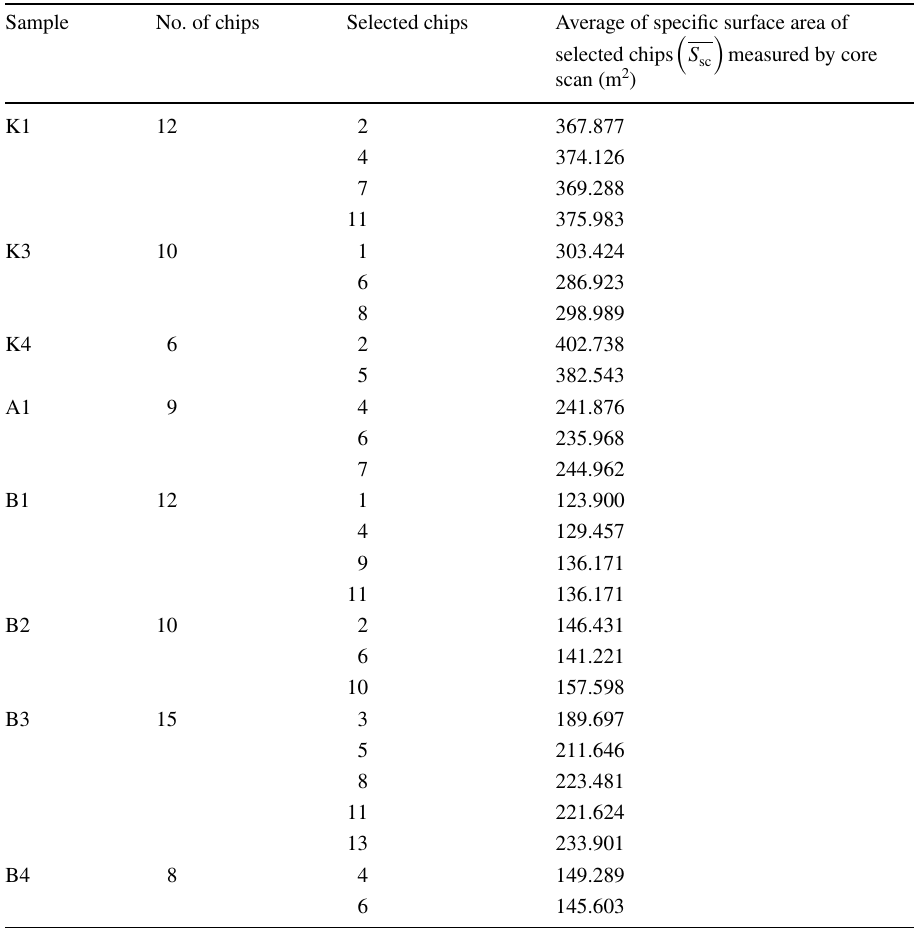
Table 6 Average specific Sample No. of chips Selected chips Average of specific surface area surface area of selected chips by core scan for all plugs